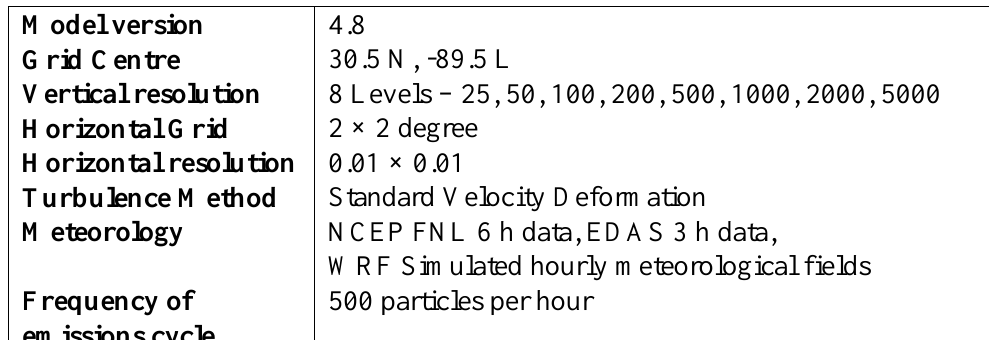
Table 3. HYSPLIT dispersion model